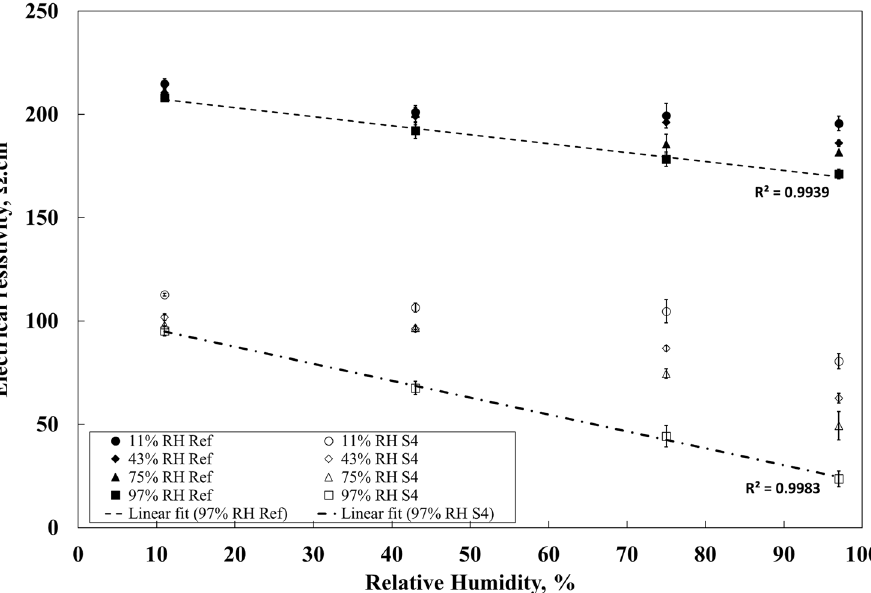
Figure 4. Effects of curing conditions used during production of sensors on the humidity sensing capability. Error bars represent standard errors.